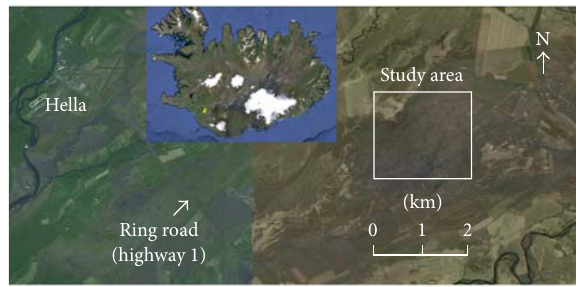
Figure 1: Location of the study area in southwestern Iceland (yellow pin on inset map). Image adapted from Google Earth. Small rectangles in study area outline are 1-hectare experimental